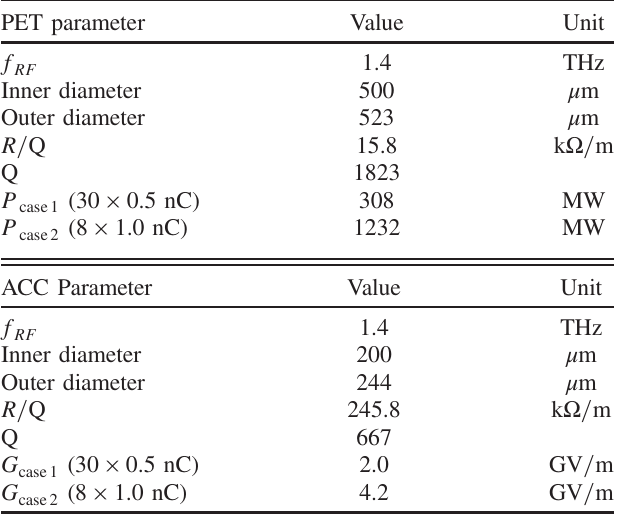
TABLE II. Preliminary THz TBA design parameters and corresponding power ( P ) and gradient ( G ) for each bunch train